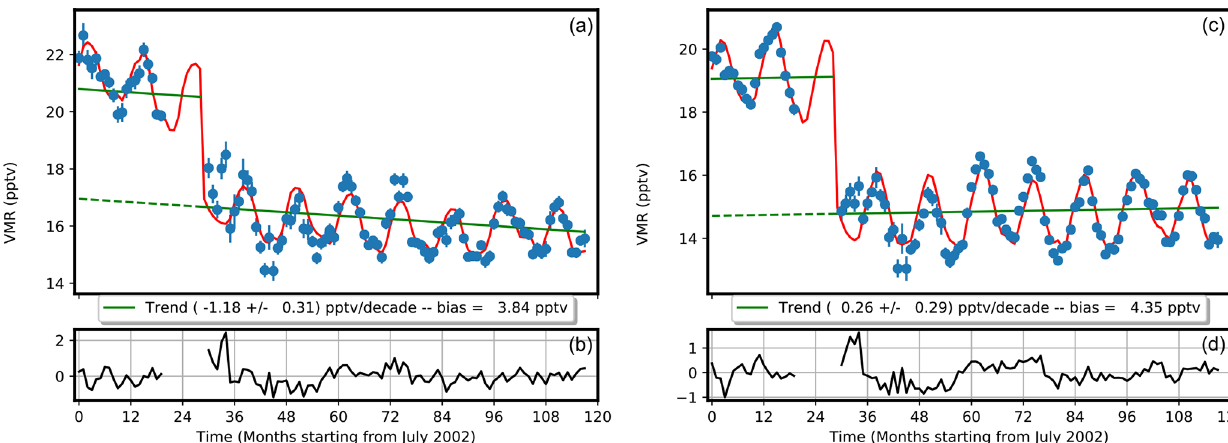
Figure 9. Blue dots are the monthly average VMRs with their error bars. The VMR (t) model and the linear term are represented by the red curve and the green line, respectively, with two different intercepts for the FR and the OR mission phases. The trend is the slope of the green lines. Panels (a) and (b) refer to the latitude bin centered at 15 ◦ N at the pressure level of 100hPa, and panels (c) and (d) refer to 25 ◦ S and 115hPa. The black lines in (b) and (d) show the residuals of the fits.